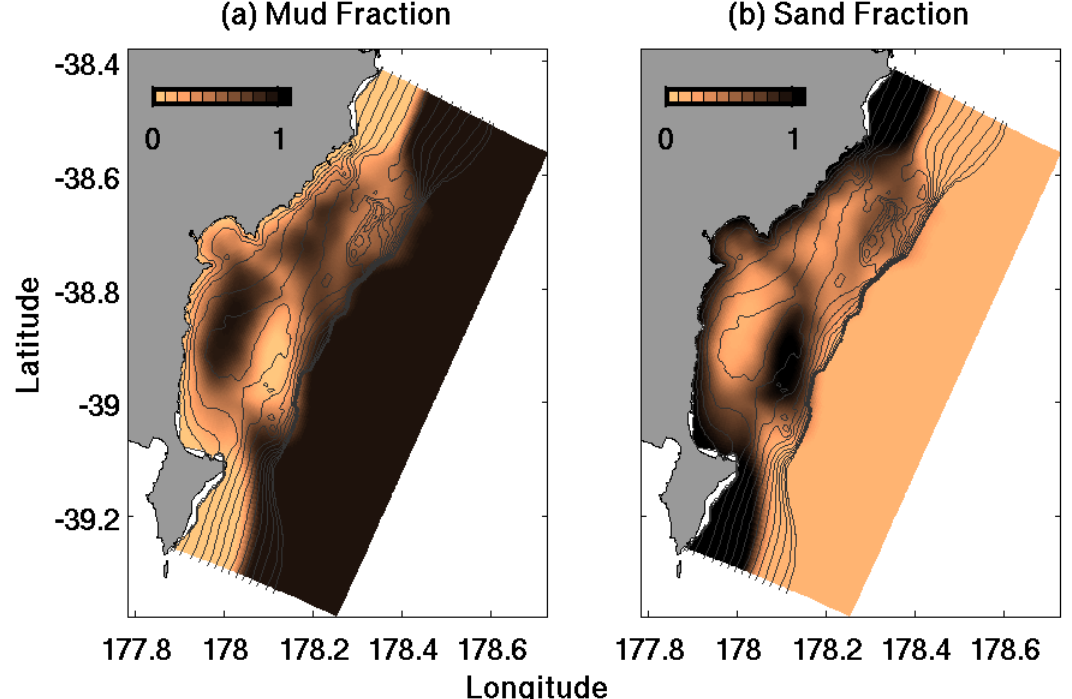
Figure 6. Initial distribution of seabed sediment classes showing fraction of ( a ) mud and ( b )